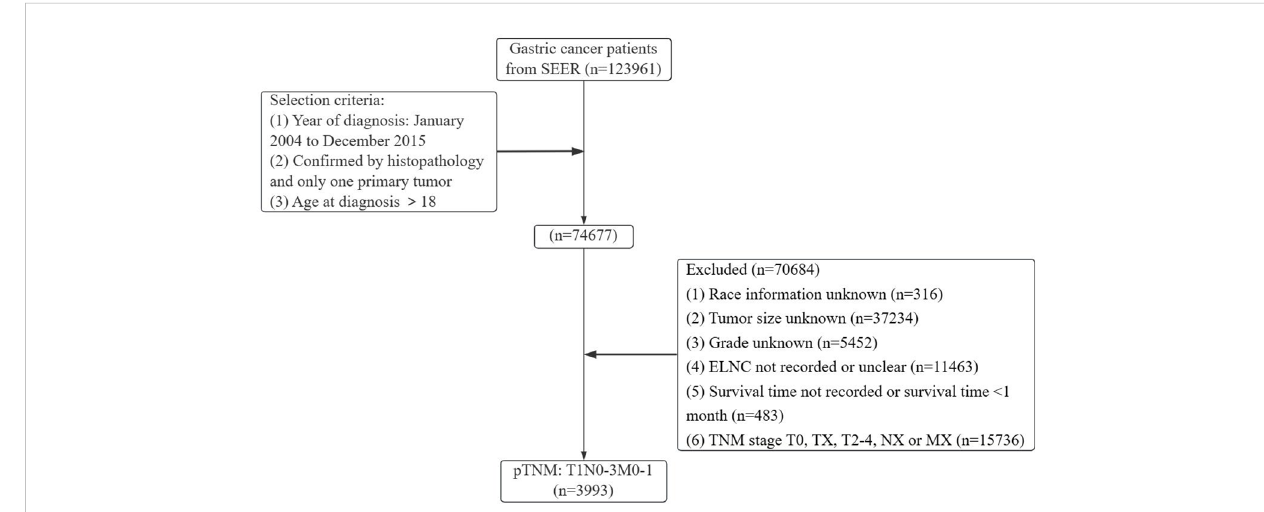
FIGURE 1 Flow chart of the patient screening process in the Surveillance, Epidemiology, and End